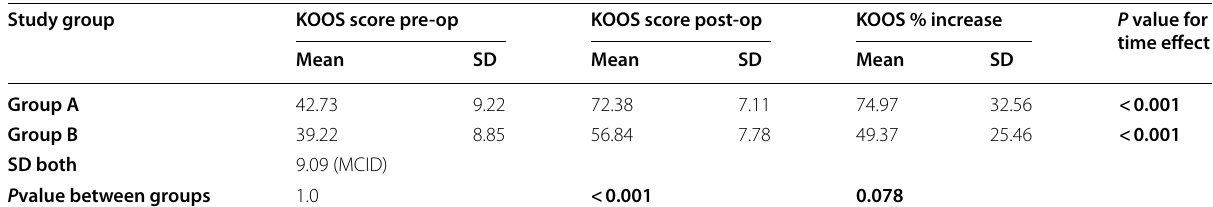
Table 5 KOOS score before treatment, after treatment with % difference from baseline in both groups